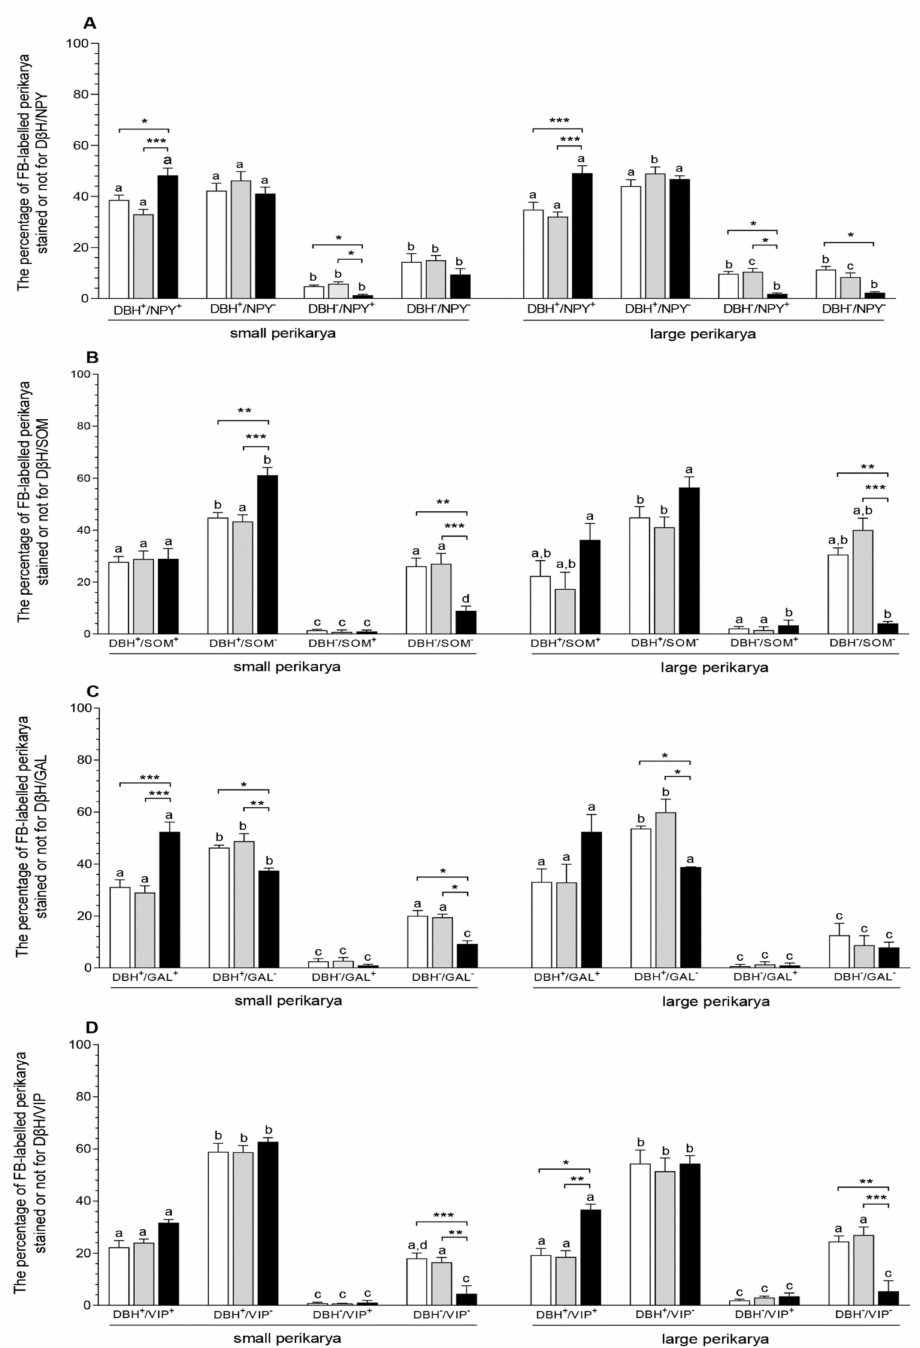
Figure 2. The populations (expressed as percentages, mean ± SEM) of small and large uterine perikarya expressingdopamine- β -hydroxylase(D β H)and / orneuropeptideY(NPY)( A ),D β Hand / orsomatostatin (SOM) ( B ), D β H and / or galanin (GAL) ( C ) and D β H and / or vasoactive intestinal polypeptide (VIP) ( D ) as well as those without these substances in the CaMG of gilts from the CON (white bars), SAL (grey bars) and E. coli (black bars) groups. Data are expressed as percentages of the total population of small or large uterine perikarya stained for two substances in each group, accepted as 100%. Di ff erent letters (a, b, c, d) show di ff erences ( p < 0.01, p < 0.001) among the particular populations of uterine perikarya within the CON, SAL and E. coli groups; * p < 0.05, ** p < 0.01 and *** p < 0.001 show di ff erences between all groups for the same population of uterine